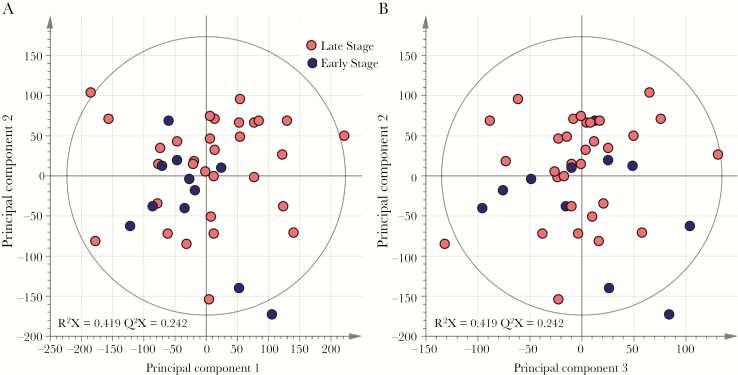
Inherent variation in cerebrospinal fluid (CSF) metabolic phenotypes is not associated with human African trypanosomiasis diagnostic stage. Principle component analysis scores plotted on the basis of 1H nuclear magnetic resonance spectral data of CSF samples show overlap of spectral data from patients with early stage disease (n = 11) and those with late-stage disease (n = 31), using the first 2 components (A) and the second and third components (B). R2X denotes the model fit parameter for variation in spectral data and describes the fraction of variance explained by model. Q2X denotes the model predictive parameter for spectral data and describes the predictive power of the model.